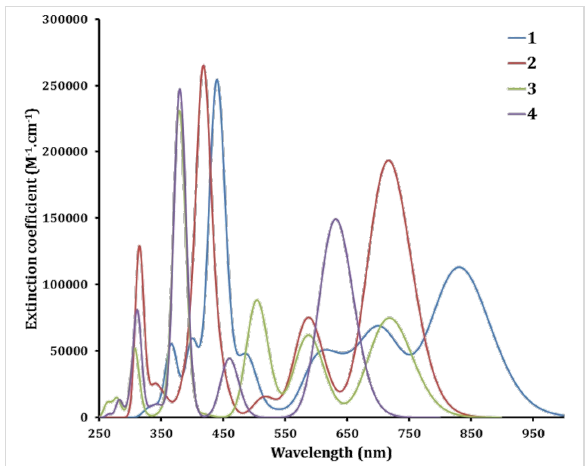
Figure 3: Predicted absorption spectra of the four